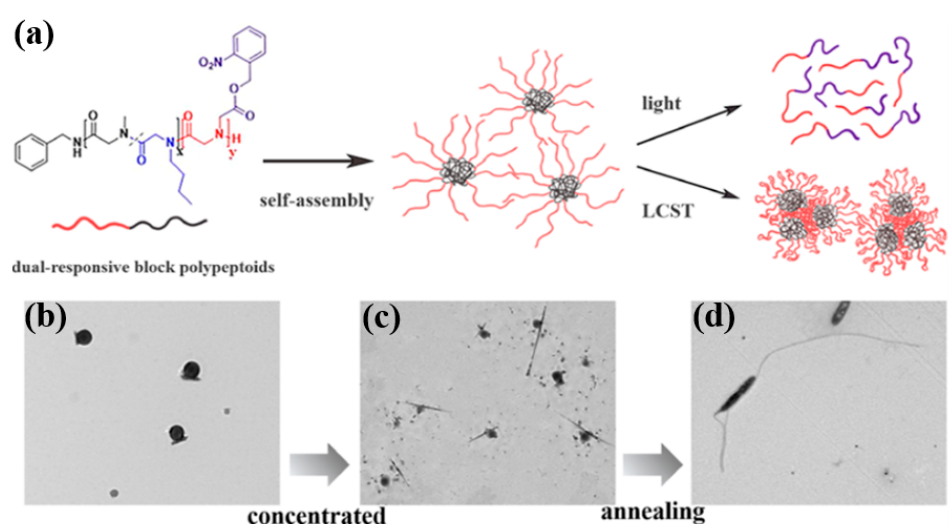
Figure 9. ( a ) Schematic illustration of dual-responsive block polypeptoids. ( b ) TEM micrograph of micelles formed by P(Sar 0.51 - r -NBG 0.49 ) 52 - b -PNB 7 in diluted aqueous solution (0.2 mg / mL). ( c ) TEM micrograph of structures formed by P(Sar 0.51 - r -NBG 0.49 ) 52 - b -PNB 7 in concentrated aqueous solution (5 mg / mL). ( d ) TEM micrograph of anisotropic structures formed by P(Sar 0.51 - r -NBG 0.49 ) 52 - b -PNB 7 in concentrated aqueous solution (5 mg / mL) after the annealing process. Reprinted with permission from [62] . Copyright 2020, American Chemical Society.